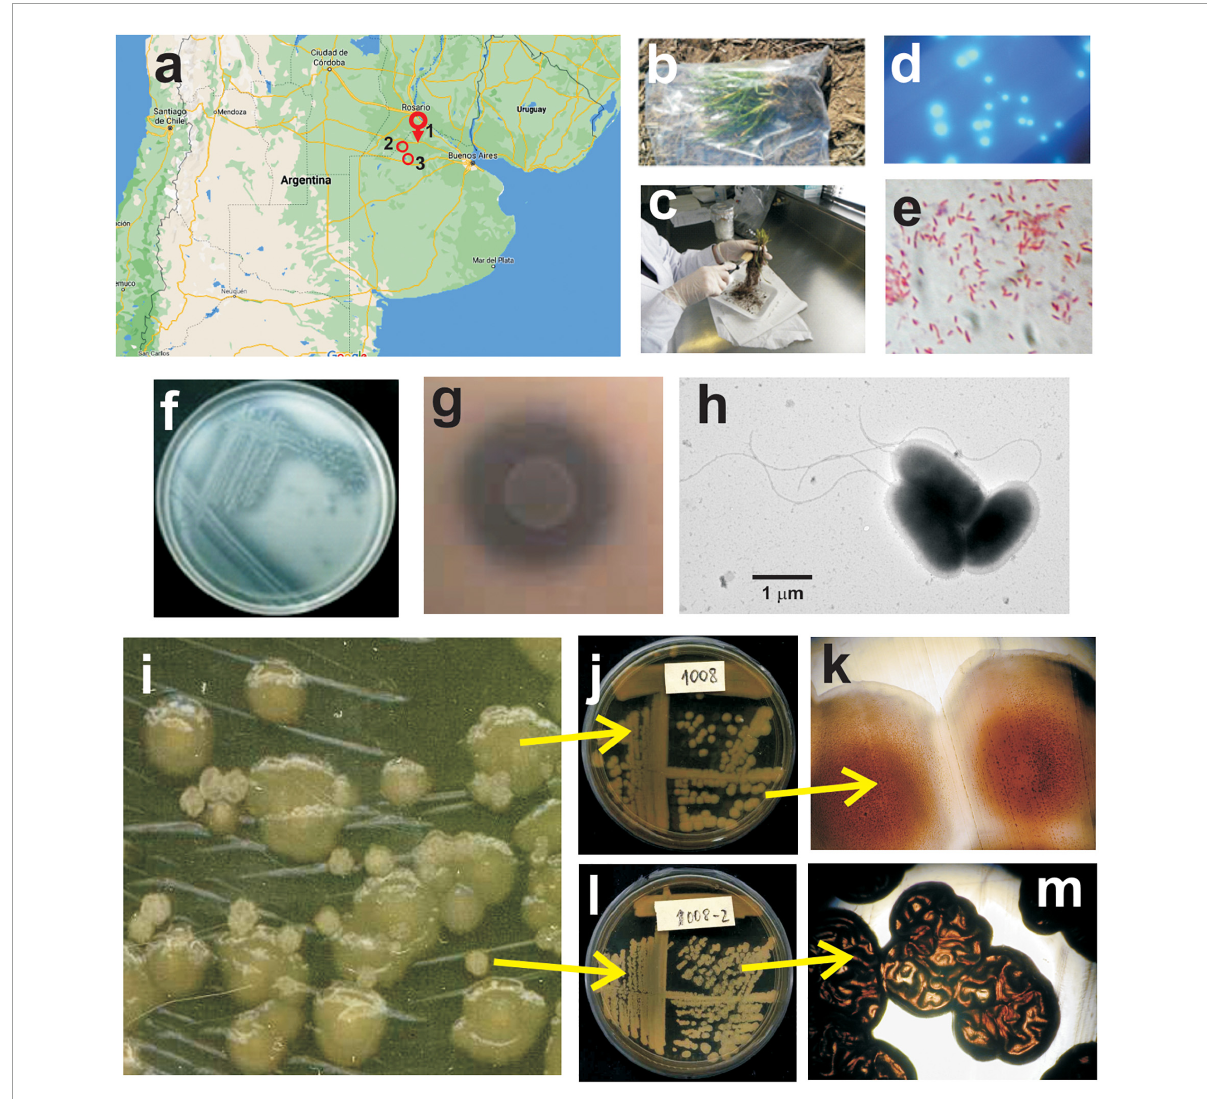
FIGURE1 Isolation and microbiological characterization of Pseudomonas sp. strain 1008. (a) Geographic location of the wheat field plot sampled for isolation of Pseudomonas strain 1008 (1, Pergamino), and of the experimental field assays for evaluation of the performance of the inoculant based on strain 1008 (1, Pergamino; 2, Ferré; 3, Junín). (b) Wheat plants sampled at tillering stage. (c) Loosely adhered soil was gently brushed away from the root system. (d) Fluorescent colonies developed on Pseudomonas agar F upon plating of dilutions of rhizospheric suspensions. (e) Gram staining of cells from a pure culture of strain 1008. (f) Streaks of strain 1008 on Pikovskaya agar with calcium triphosphate as P source. (g) Close up of a macrocolony of strain 1008 and the surrounding calcium triphosphate solubilization halo on Pikovskaya agar. (h) Transmission electron micrograph showing cells of strain 1008 grown for 24 h in nutrient yeast broth at 28 ◦ C and 200 rpm. Note the flagella with a typical polar location. (i) Colony phase variants of strain 1008 on nutrient agar plates. The larger colonies correspond to phase variant 1 (j,k) whereas the smaller colonies correspond to phase variant 2 (l,m) . The colony morphotype of each variant is clearly distinct under magnifying lens (k,m) .